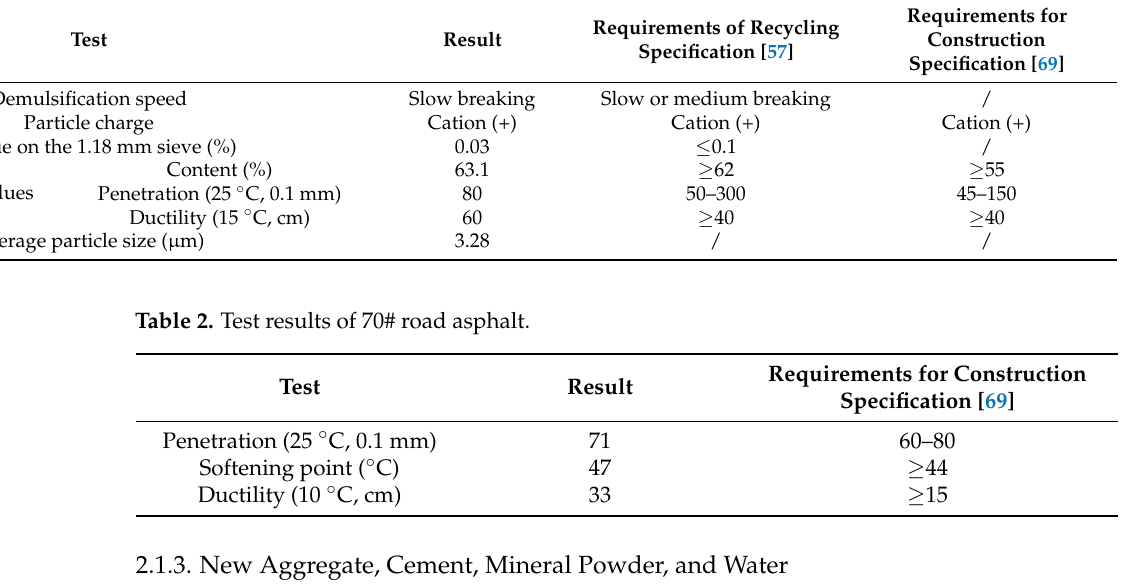
Table 1. Test results of emulsified asphalt.